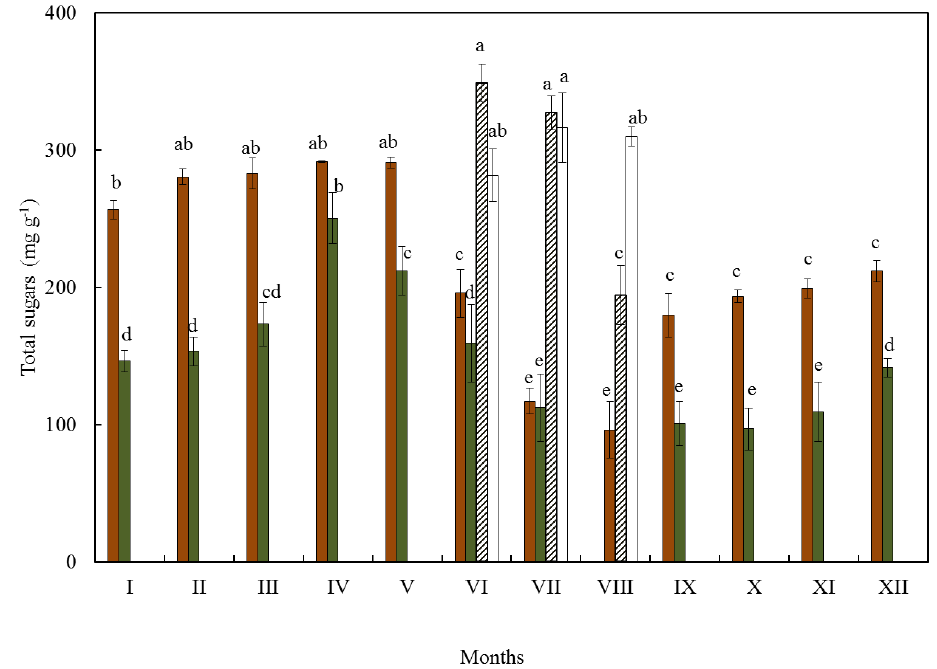
Figure 1. Sugar content in bulbs (brown bars), expanded leaves (green bars), scapes (dashed bars), and petals (white bars) of Pancratium maritimum , from January (I) to December (XII). Each column denotes means of five replicates ± Standard Error. Significant differences ( p ≤ 0.05) of mean values are presented by different lowercase letters (a–e) on bars.